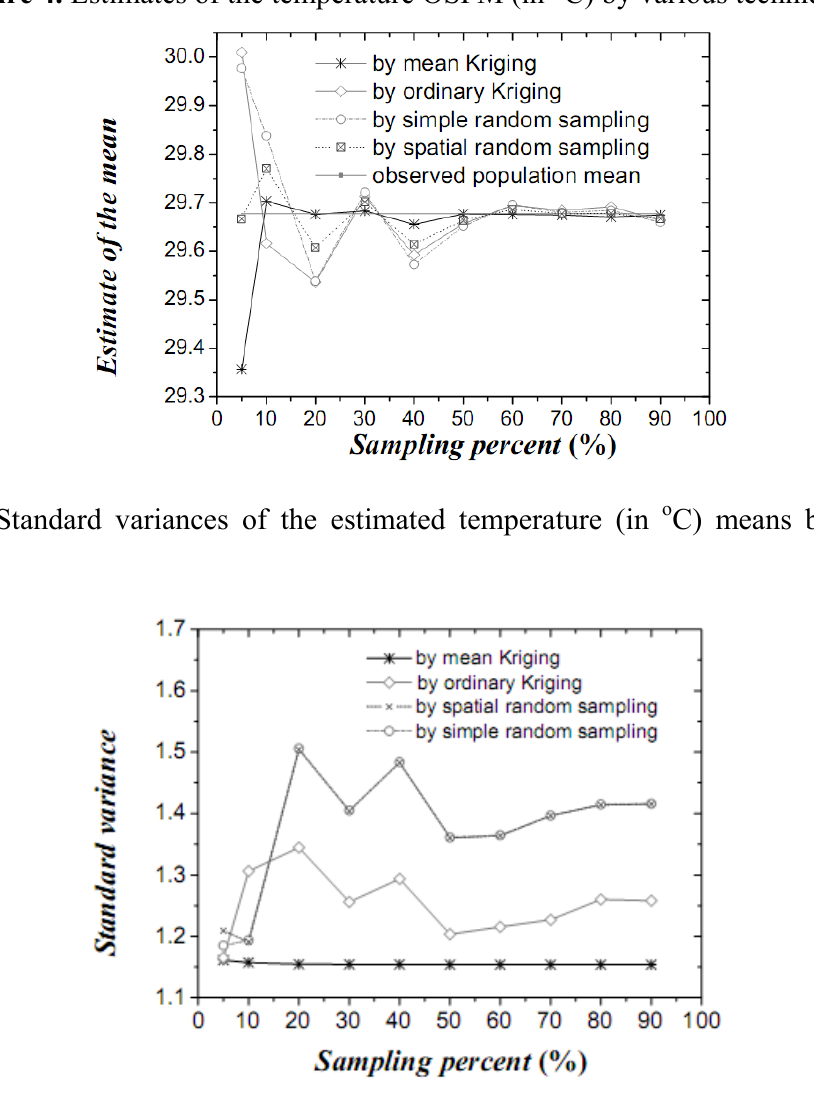
Figure 4. Estimates of the temperature OSPM (in °C) by various techniques.